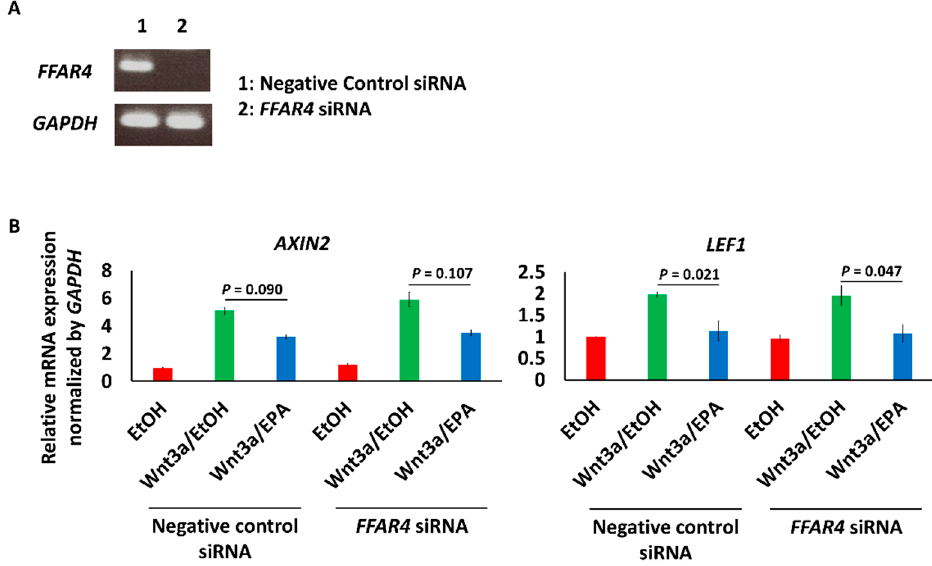
Figure 5. Effect of the knockdown of FFAR4 on Wnt signaling in HAoSMCs. ( A ) The knockdown of FFAR4 in HAoSMCs was confirmed by RT-PCR; ( B ) The effect of knockdown of FFAR4 on the expression of AXIN2 and LEF1 , downstream genes of Wnt signaling. Data are shown as means ± SE ( n = 3 in each group) and were analyzed using one-way ANOVA with Tukey’s post hoc